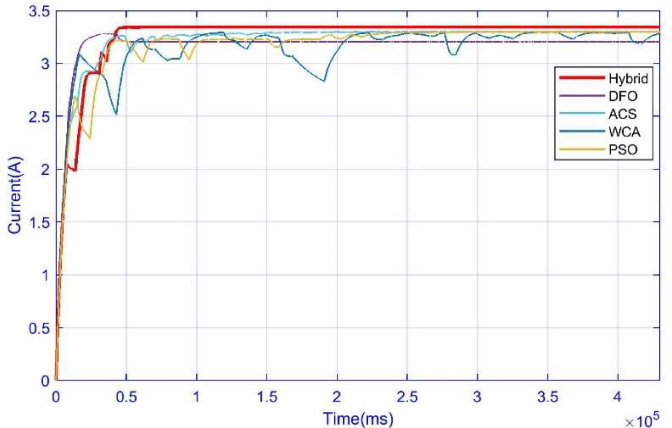
Figure 15. Case 3: Current comparison of hybrid with other techniques.